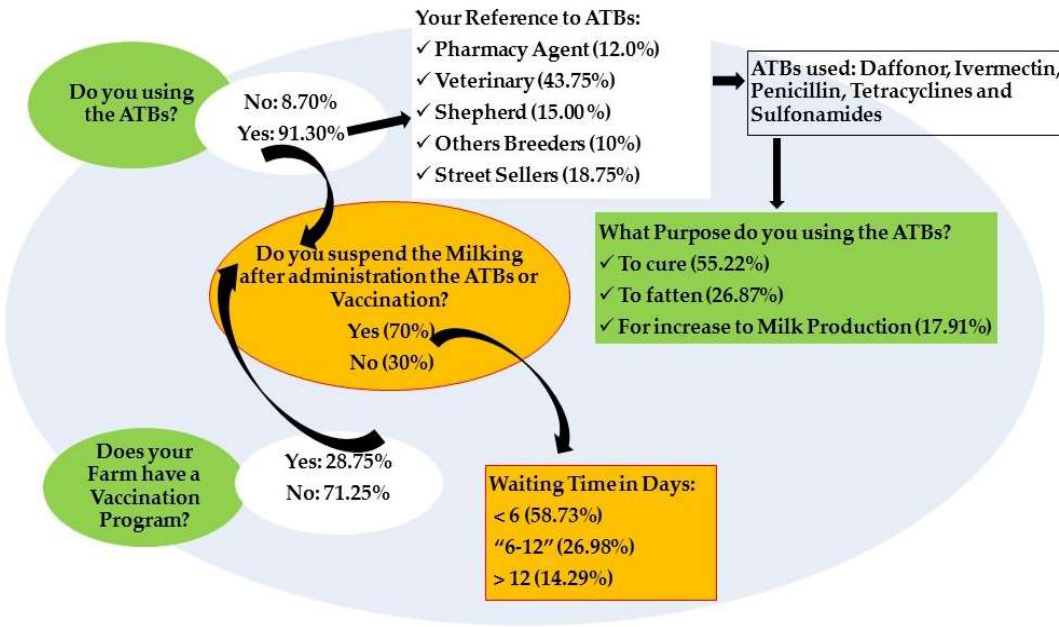
Figure 3. Synthesis on the use of antibiotics and vaccination of